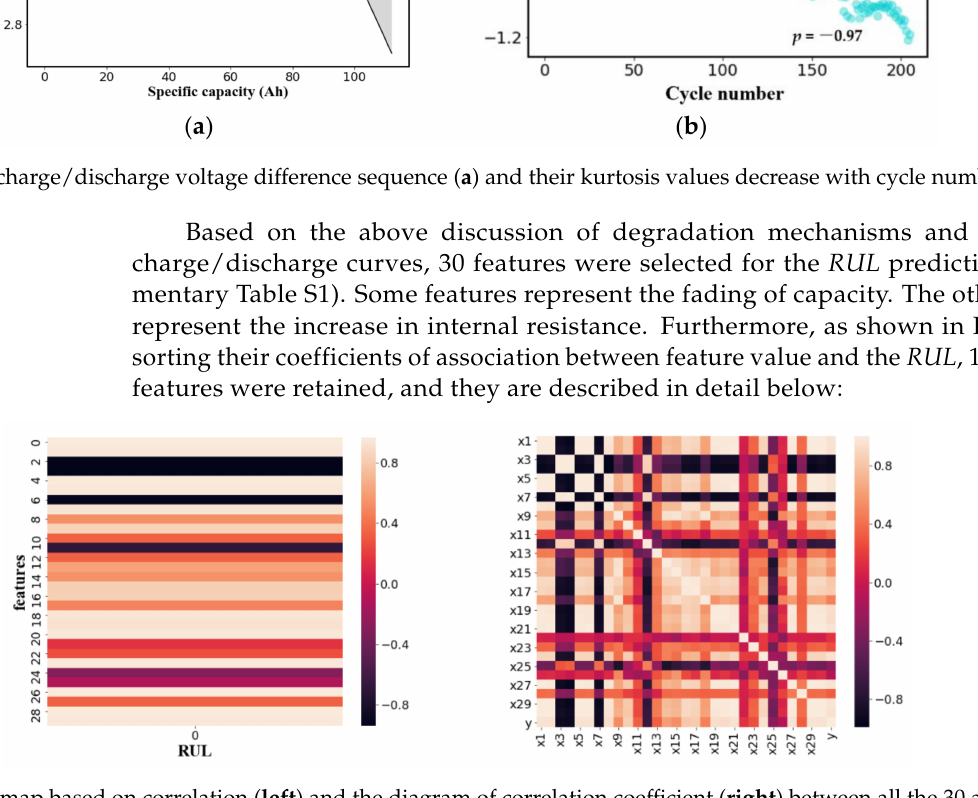
Figure 4. Heatmap based on correlation ( left ) and the diagram of correlation coefficient ( right ) between all the 30 available features and RUL . The importance of each feature can be observed